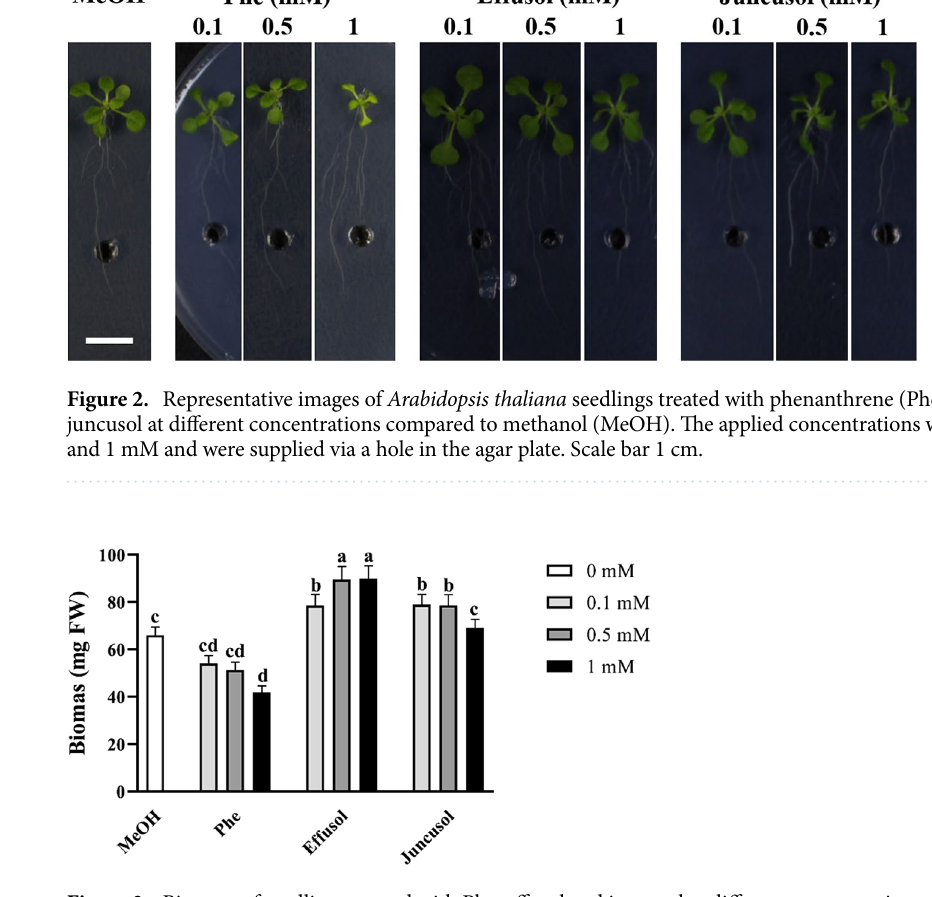
Figure 3. Biomass of seedlings treated with Phe, effusol and juncusol at different concentrations compared to MeOH. Data are presented as the mean ± SE (n = 30). Different letters indicate significant differences